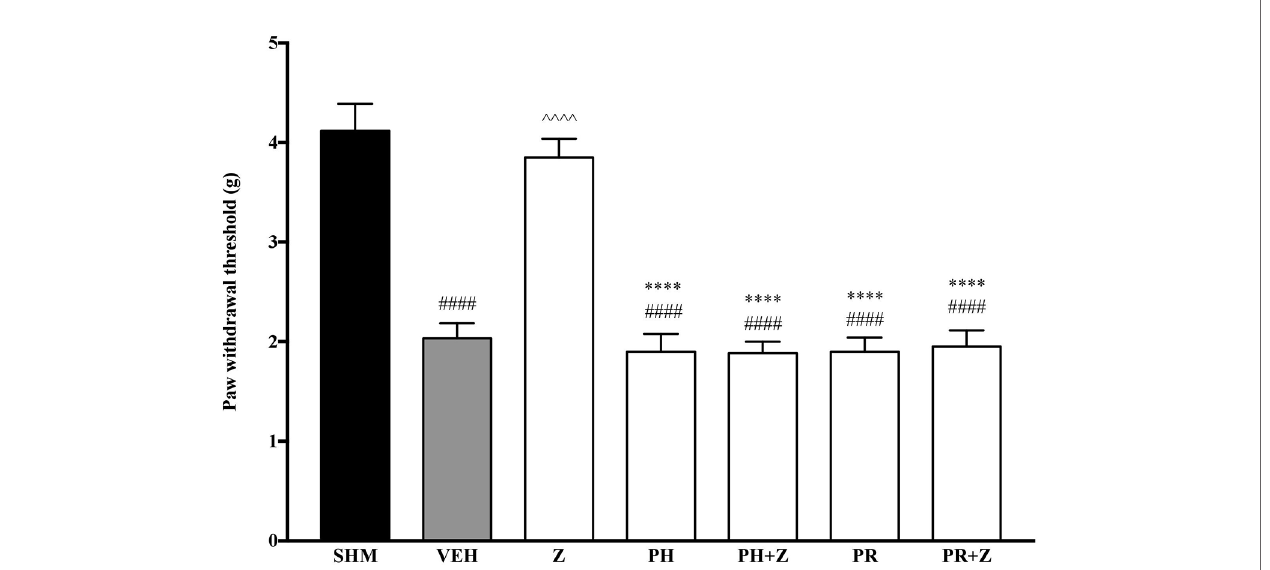
FIGURE 1 | Effect of phentolamine (non-selective a -adrenoceptor antagonist) and propranolol (non-selective b -adrenoceptor antagonist) pre-treatment on zerumbone against mechanical allodynia in CCI-induced neuropathic pain mice. Data are presented as mean ± SEM (n = 6). #### p < 0.0001 as compared to sham, ^^^^ p < 0.0001 as compared to vehicle and **** p < 0.0001 as compared to zerumbone-treated group. SHM (Sham); VEH (Vehicle, 10 mL/kg i.p.); Z (Zerumbone, 10 mg/kg i.p.); PH (Phentolamine, 5 mg/kg i.p.); PR (Propranolol, 5 mg/kg